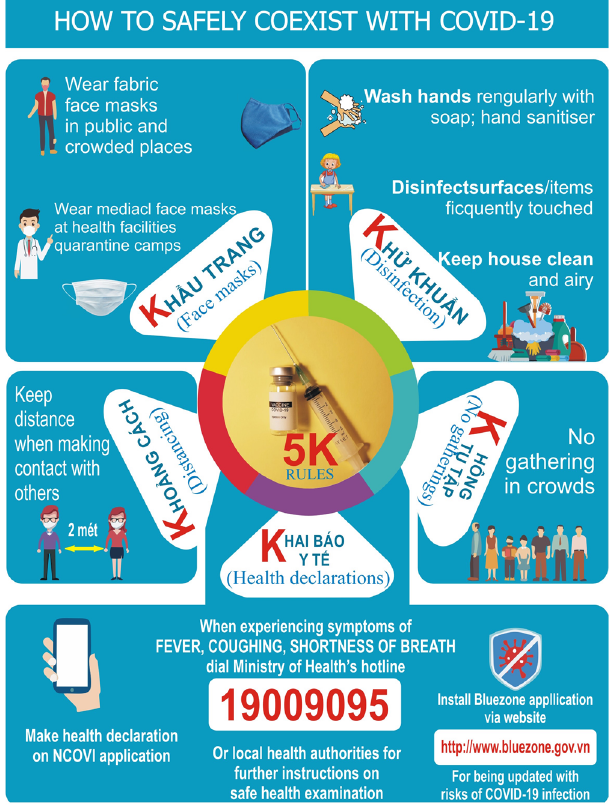
Figure 1. The 5K Message and Vaccination to Safely Co-exist with COVID-19 in Vietnam. Source: Vietnamese Ministry of Health, 2020.